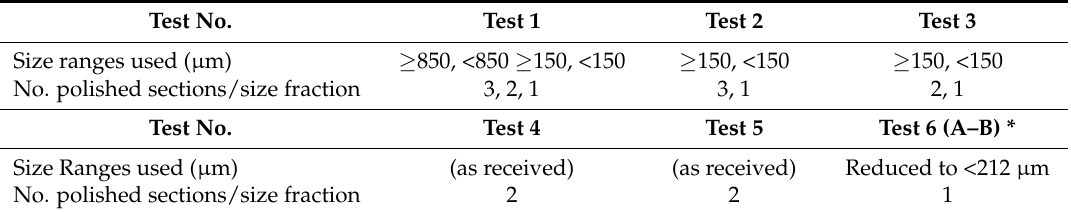
Table 3. Sample preparation scheme for particle and mineral segregation